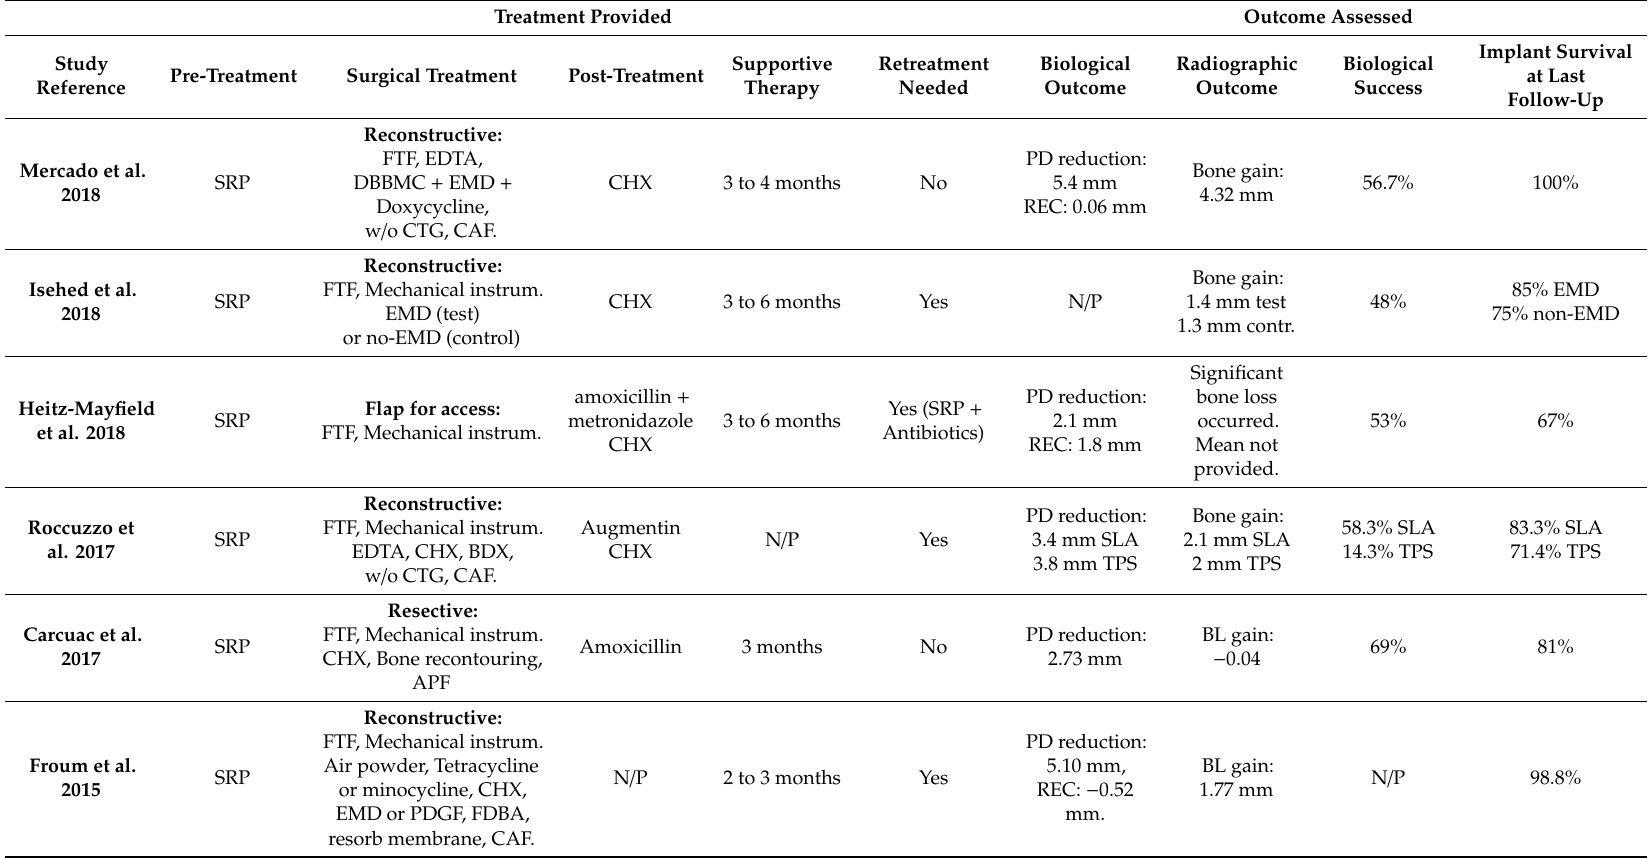
Table 3. Intervention, clinical and radiological outcome of included articles. Abbreviations, APF: apically positioned flap. BDX: bovine-derived xenograft. CAF: coronally advanced flap. CHX: chlorhexidine. CPS: plastic curets + cotton pellets soaked in sterile saline. CTG: connective tissue graft. DBBMC: deproteinized bovine bone mineral with 10% collagen. EDTA: ethylenediaminetetraacetic acid. EMD: enamel matrix derivative. ERL: erbium-doped yttrium aluminum garnet laser. FDBA: freeze-dried bone allograft. FTF: full thickness flap. NBM: bovine-derived natural bone mineral. NHA: nanocrystalline hydroxyapatite. NBM + CM: natural bone mineral with a collagen membrane. N / P: not provided. PDGF: platelet-derived growth factor. SRP: scaling and root planning. SLA: sandblasted acid-etched. TPS: titanium plasma-sprayed. w / o: with or